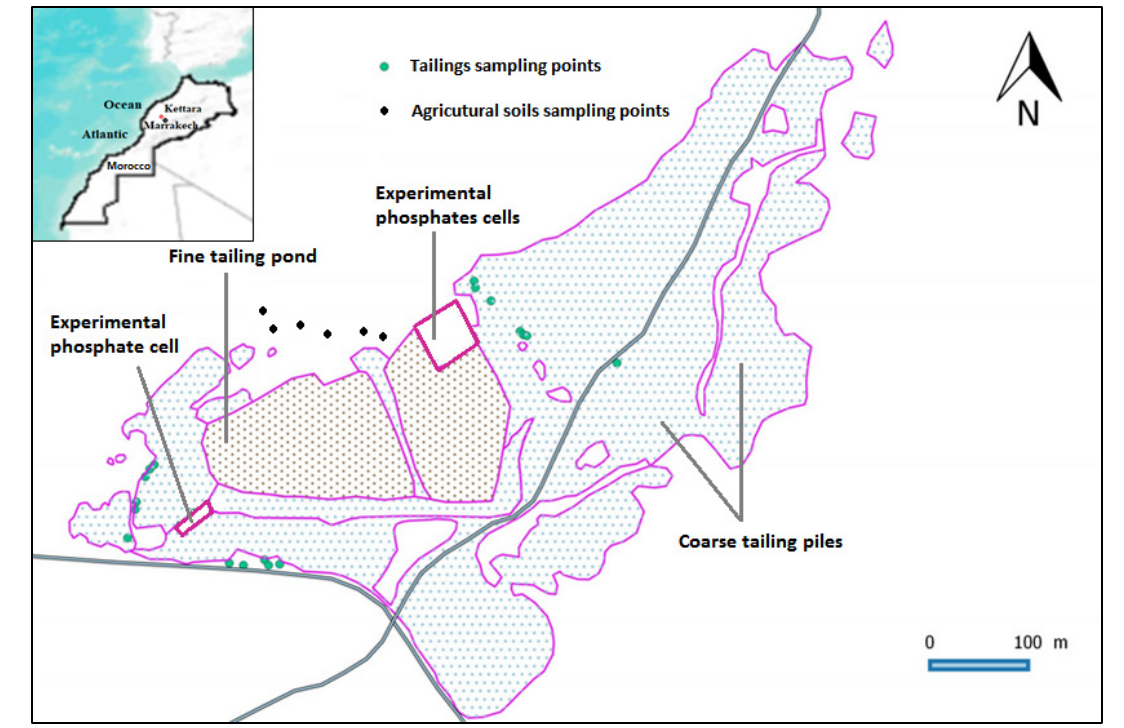
Figure 1. Geographical location of Kettara mine site and location of sampling area on tailings and agricultural soils.